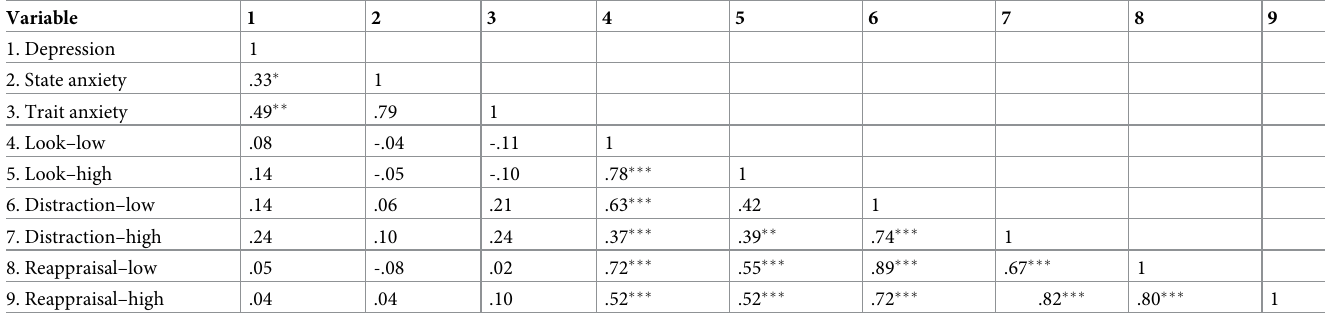
Table 3. Zero-order correlations between depression, anxiety, and the different conditions in Experiment 1B.